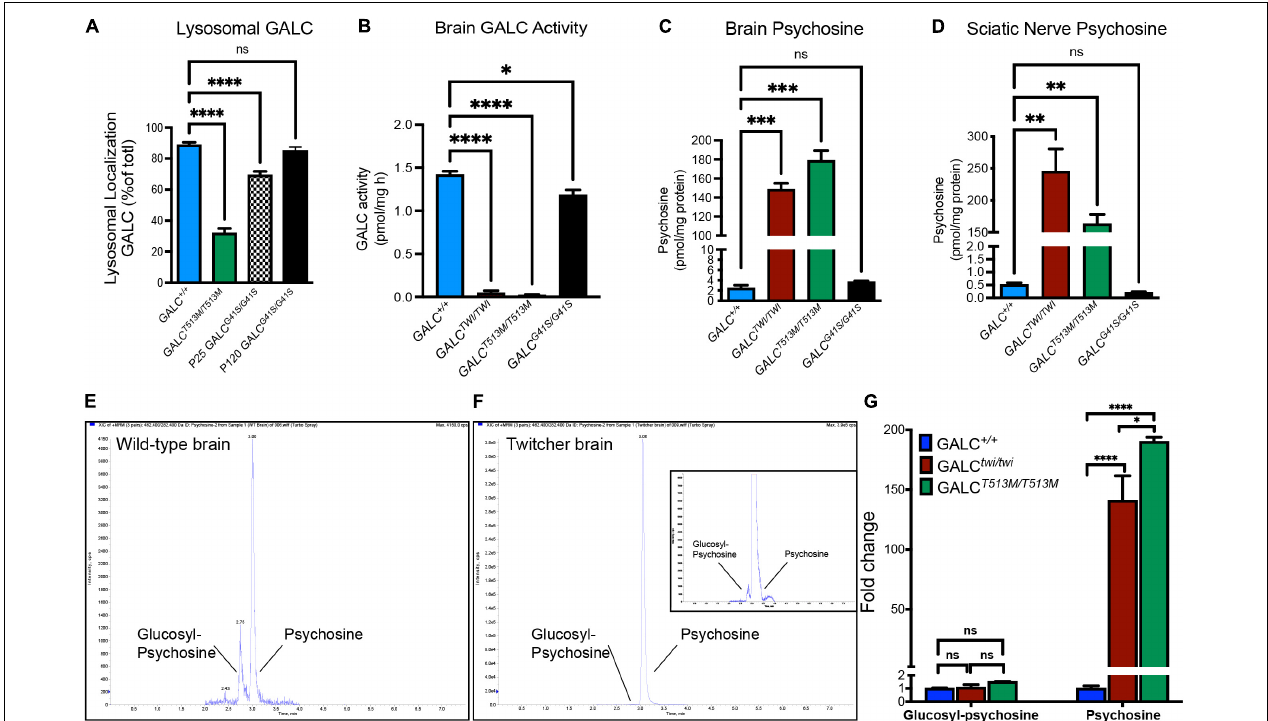
FIGURE 2 | Analysis of mutated GALC activity and psychosine production in GALC T 513 M / T 513 M and GALC G 41 S / G 41 S mice. (A) Co-localization of GALC in lysosomes was measured by confocal analysis of brain cortices of each genotype. Data represent the fraction (as%) of total GALC+ puncta that was co-stained with Lamp2+. Counts were done on random areas of the brain cortex. (B) GALC activity was analyzed fluorometrically in protein extracts from P40 brains. (C,D) Psychosine levels in P40 brains (C) and sciatic nerve (D) were measured by LC-MS-MS. (E–G) Chromatograms of glucosylsphingosine and psychosine in WT (E) and twitcher mouse brains (F) were detected by mass spectrometry. The glucosylsphingosine and psychosine were measured as the fold changes in the brain of Twi and GALC T 513 M / T 513 M mutants versus WT (G) . Data represent the mean ± SEM of 4–6 mice/genotype, analyzed by ANOVA/Tukey’s post hoc test ∗ p < 0.05, ∗∗ p < 0.01, ∗∗∗ p < 0.001, ∗∗∗∗ p <